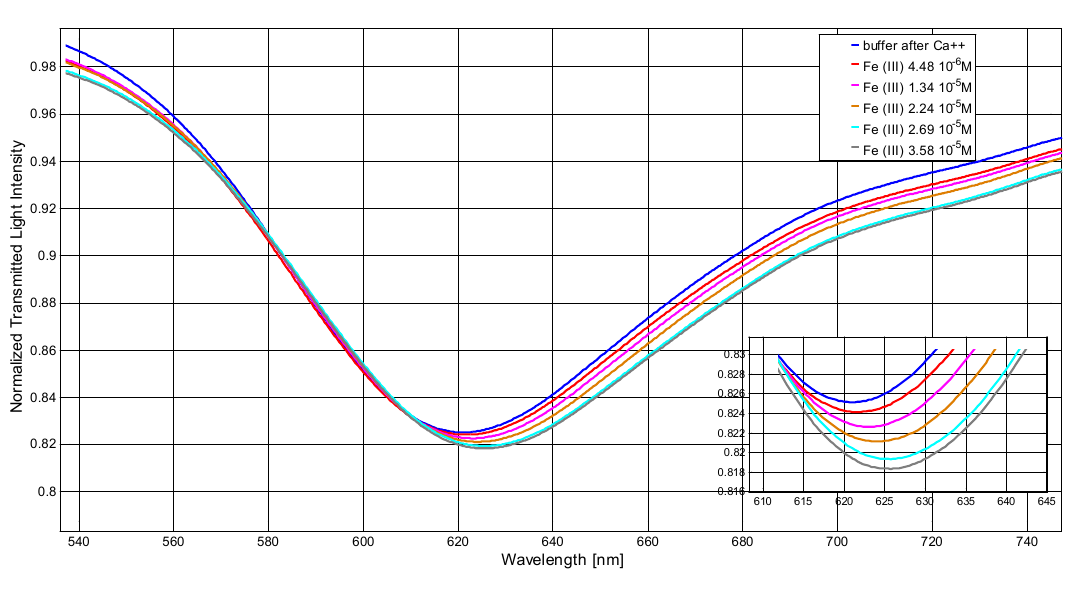
Figure 5. SPR transmission spectra obtained on DFO-SAM-POF sensor for different concentrations of Fe(III). The sensor has been conditioned in Ca 2+ 5 × 10 − 4 M. Inset: Zoom of the resonance wavelengths